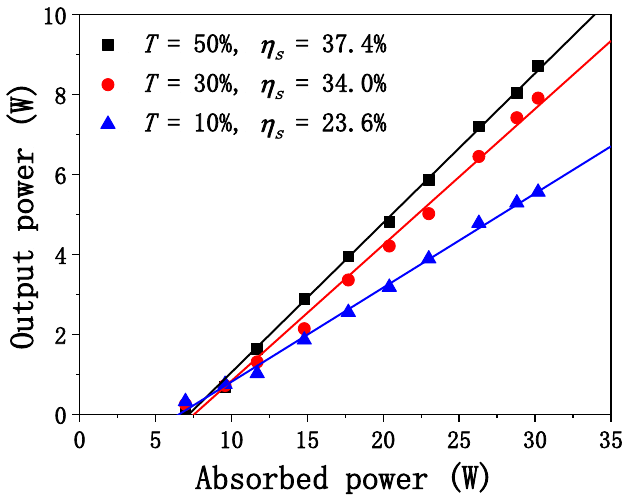
Figure 3. Output power dependence on the absorbed pump power of the Ho:YVO 4 laser. The output spectrums of the Ho:YVO 4 laser at different transmittances of the output mirrors (shown in the Figure 4) were measured with the spectrum analyzer Bristol 721A (with a resolution of ± 0.2 ppm). The central wavelength was 2066.1 nm at an output mirror transmittance of 10%. The laser emission line width (FWHM) was less than 1 nm. With the other two transmittances, the central wavelengths were blue-shifted to 2052.4 nm, which can be attributed to the low resonator loss. With the three transmittances of the output mirrors, there were no other emission peaks observed in the